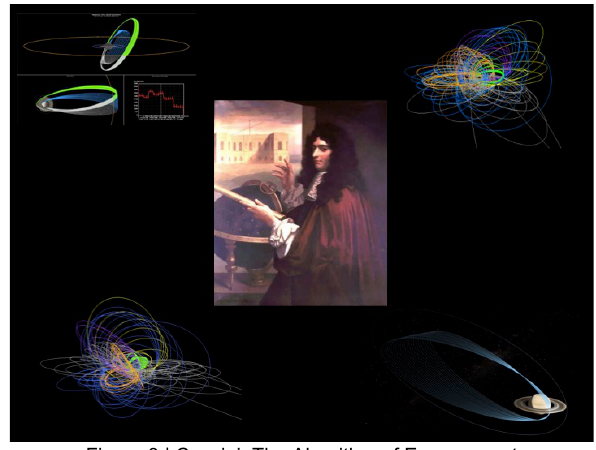
Figure 3 | Cassini, The Algorithm of Engagement The parameters and visual language of my strategic alliance with Cassini were defined through the process of interacting with the platform’s interface and database, from the choice of the listing’s category to its full descriptive text and the images